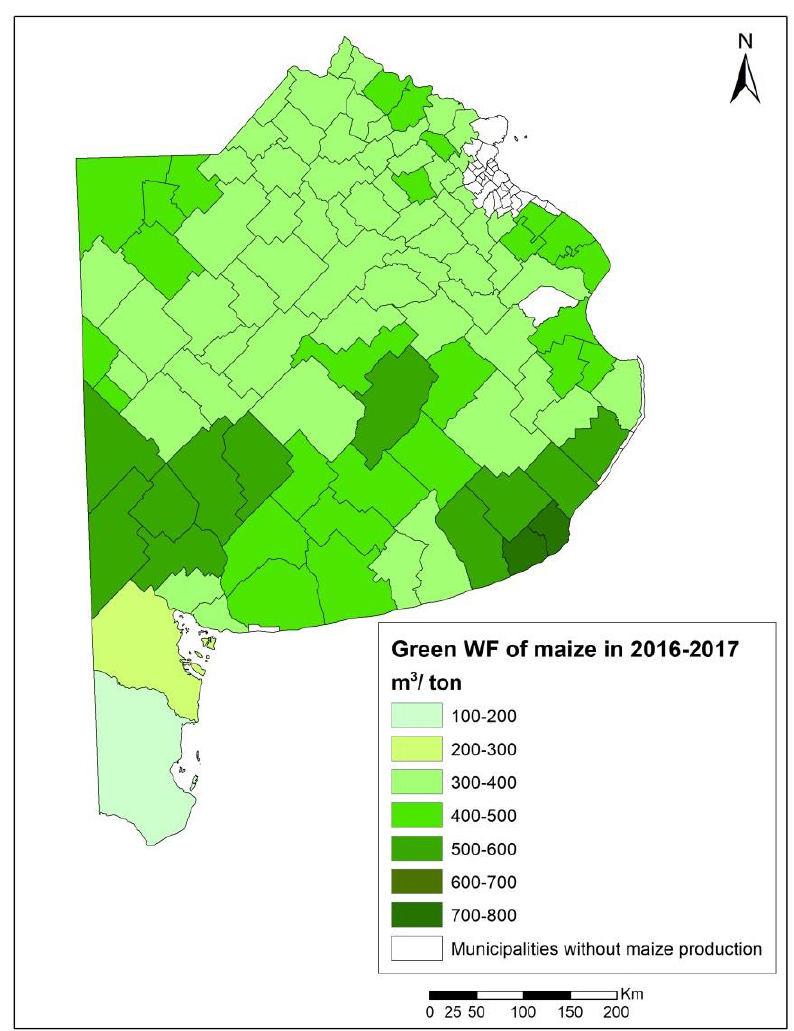
Figure 5. Green water footprint of maize in 2016–2017 at the municipality level in Buenos Aires province (m 3/ ton).